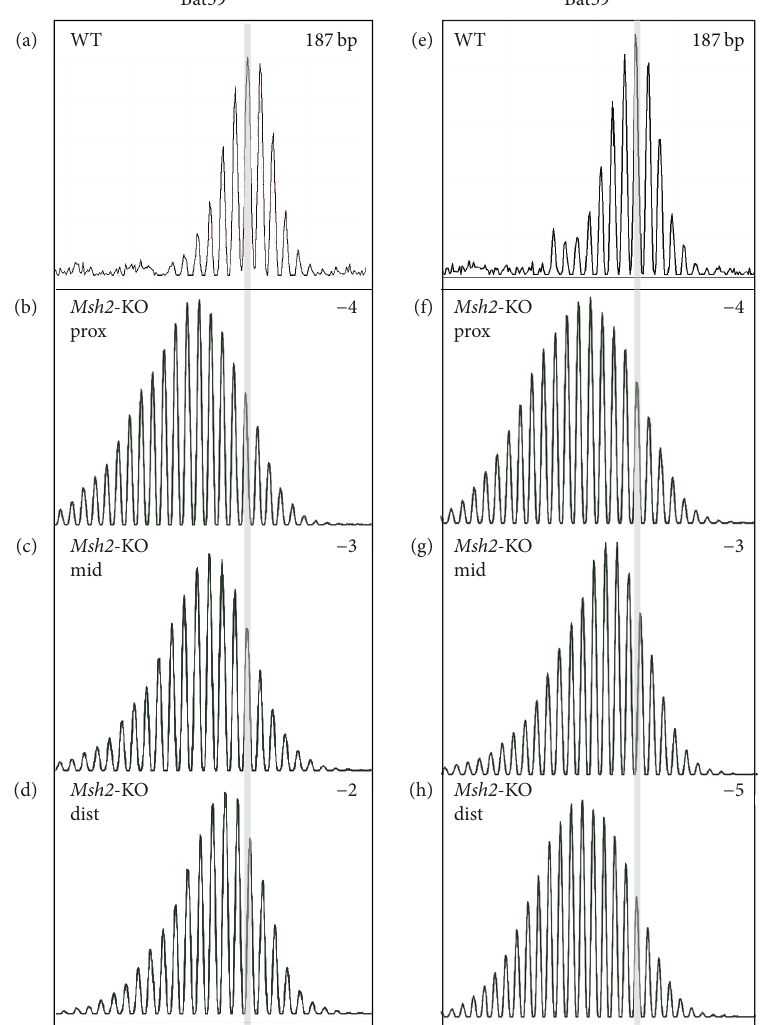
Figure 2: The length of the Bat59 mononucleotide repeat varies slightly within individual Msh2 -KO mice. (a, e) Bat59 in the colon of two WT mice; (b–d); (f–h) Bat59 in the proximal, mid, and distal colon of two Msh2 -KO mice. The position of the highest peak in the WT mouse is highlighted with the grey bar; 187 bp refers to the size of the PCR fragment in the WT and the number in the top right corner indicates the number of nucleotides by which the repeat is shortened in each Msh2 -KO